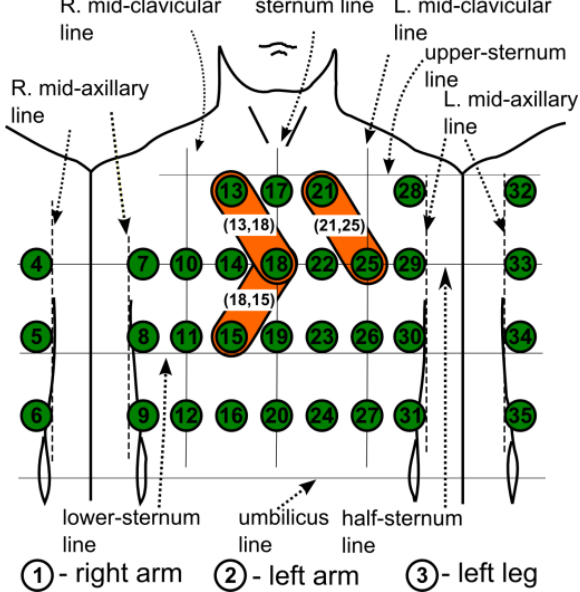
Figure 1. Schematic locations and numbering of 35-channel MECG electrodes on the chest. Potential differences between neighboring electrodes, e.g., (13,18), (21,25), (18,15), (14,19), (22,23), (31,35), etc. , are denoted as differential leads